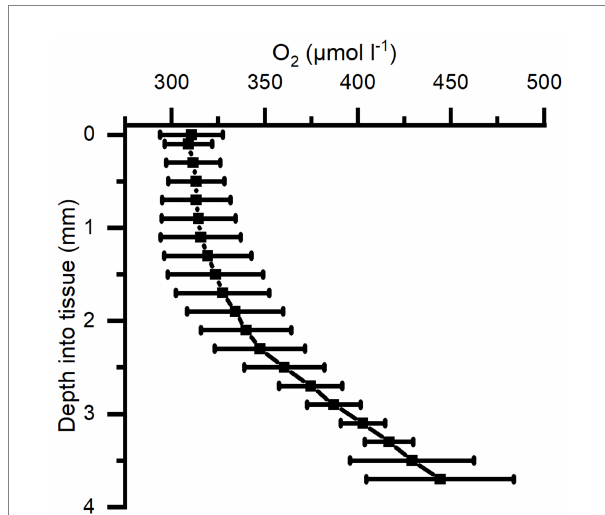
FIGURE 4 Average of depth profiles of O 2 concentration in Cassiopea tissue measured under a photon irradiance (400–700 nm) of 300 μ mol photons m − 2 s − 1 in the bell of a medusae. n = 3 biological replicates with 1 profile each.